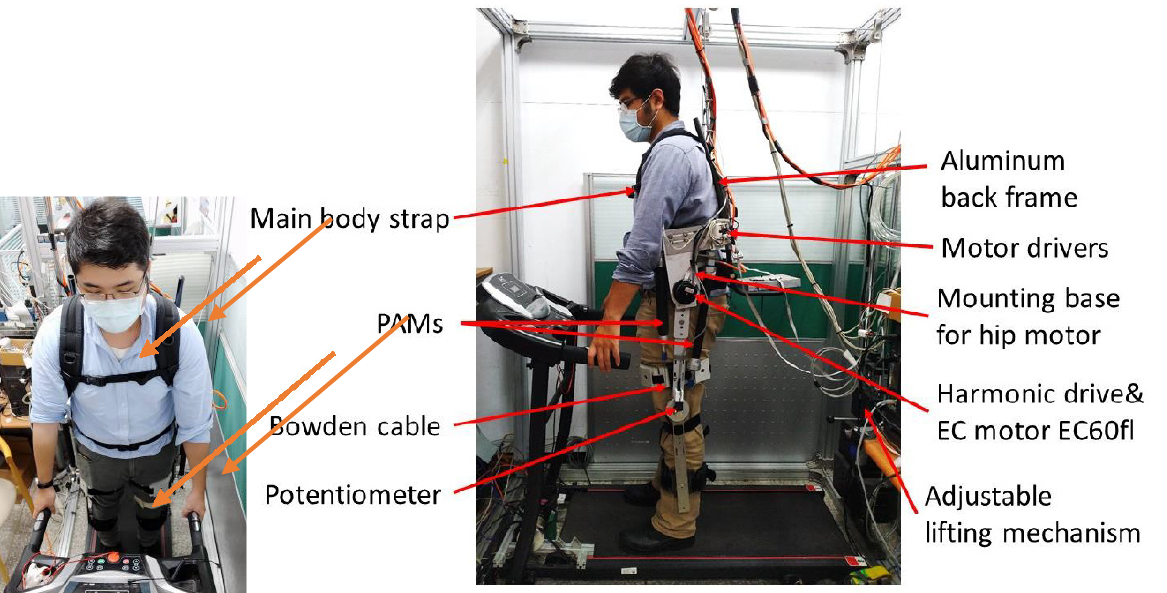
Figure 2. Hip joint exoskeleton design.